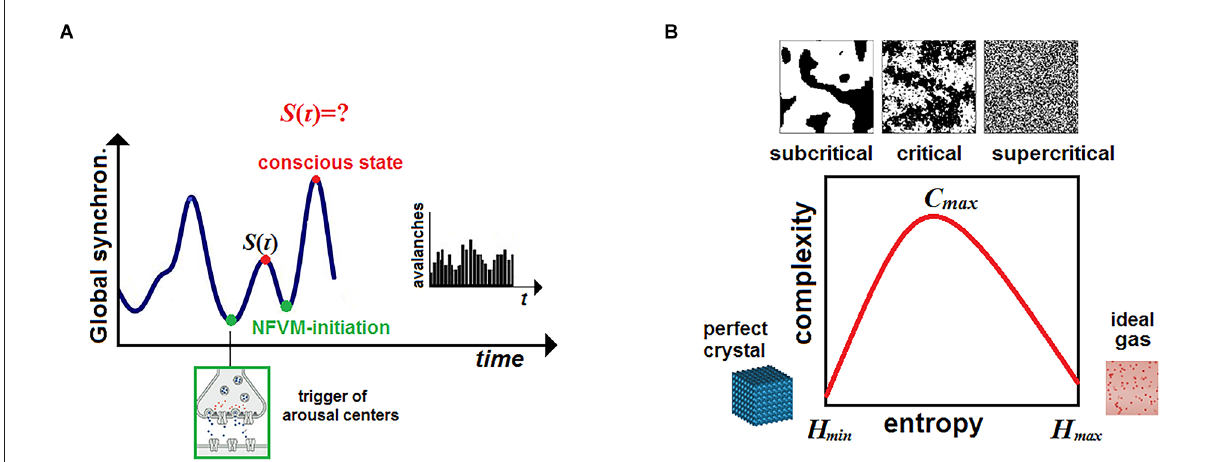
FIGURE2 Criticaldynamics,phasetransitionsandtheNFVM. (A) Incriticaldynamics,oneneuronexcitesanotherandcausesavalanchesofactivityspreading across N and obeying the power law of distribution. The brain exhibits a broad range of flexible patterns of coordinated dynamics which decay after some critical value. While the NFVM initiates avalanches from arousal centers, a decentralized feedback mechanism arises spontaneously to lead a self-organized system from subcritical to supercritical phases. (B) A simulation of critical phase transitions on the 2D Ising spin lattice model exhibits different degrees of synchronization or coordination (black dots) from subcritical to supercritical states as temperature (a control parameter) increases from left to right. Adopted from Kitzbichler et al. (2009). Complexity as an entropy-based measure placed between two thermodynamic extrema: a perfect crystal at absolute zero temperature and an ideal gas. C N reflects a mixture of integration/segregation in brain dynamics with maximal values near criticality between subcritical and supercritical phases presented